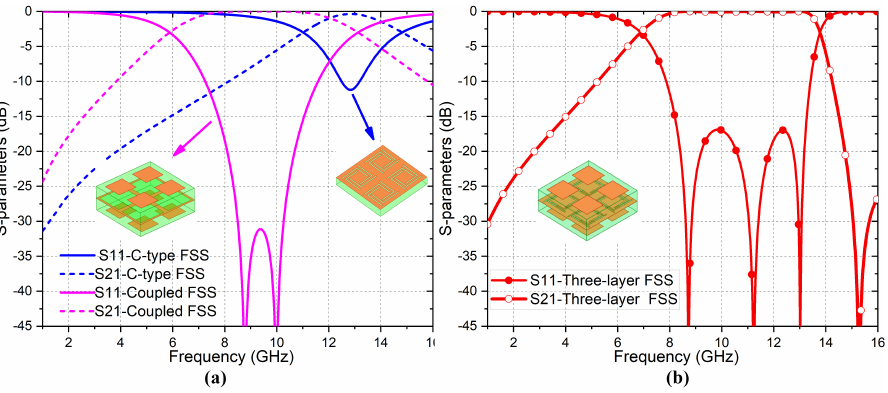
Figure 5. Comparison of transmission characteristics between different FSS. ( a ) Transmission/ reflection coefficients of the C-type FSS and coupled FSS. ( b ) Transmission/reflection coefficients of the three-layer